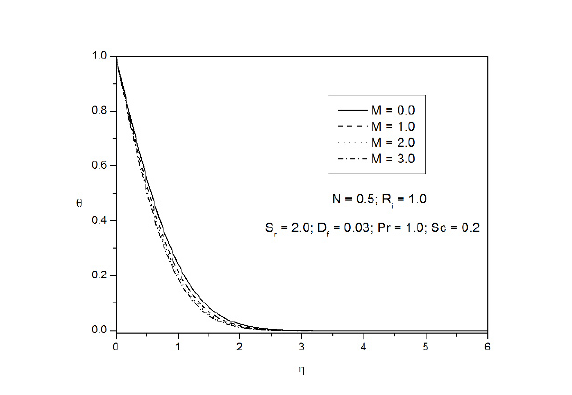
Figure 5. Effect of mixed convection parameter R Rate